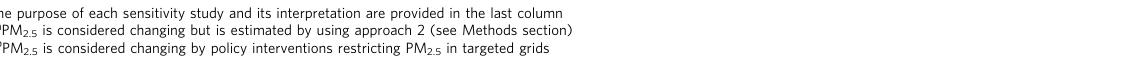
respectively, in the near, distant and far future. The shaded areas in Fig. 3 represent the range of uncertainty in premature mortality estimates across the country. The upper and lower ranges around the mean values are estimated using the mean ± 1 σ PM 2.5 exposure (where σ is the error) for each grid obtained from 13 CMIP5 models and the mean ± 1 σ values of the coef fi cients used in the GDP – baseline mortality relation 10 . In contrast to a recent study 19 that projects a decrease in premature mortality burden below the present-day level after 2050 in India